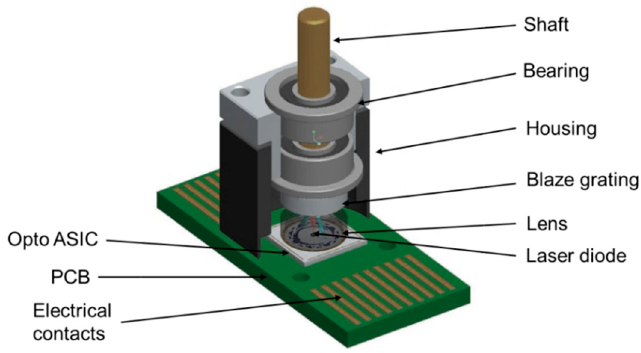
Figure 12. Cross-section of the demonstrator for the miniaturized optical encoder.